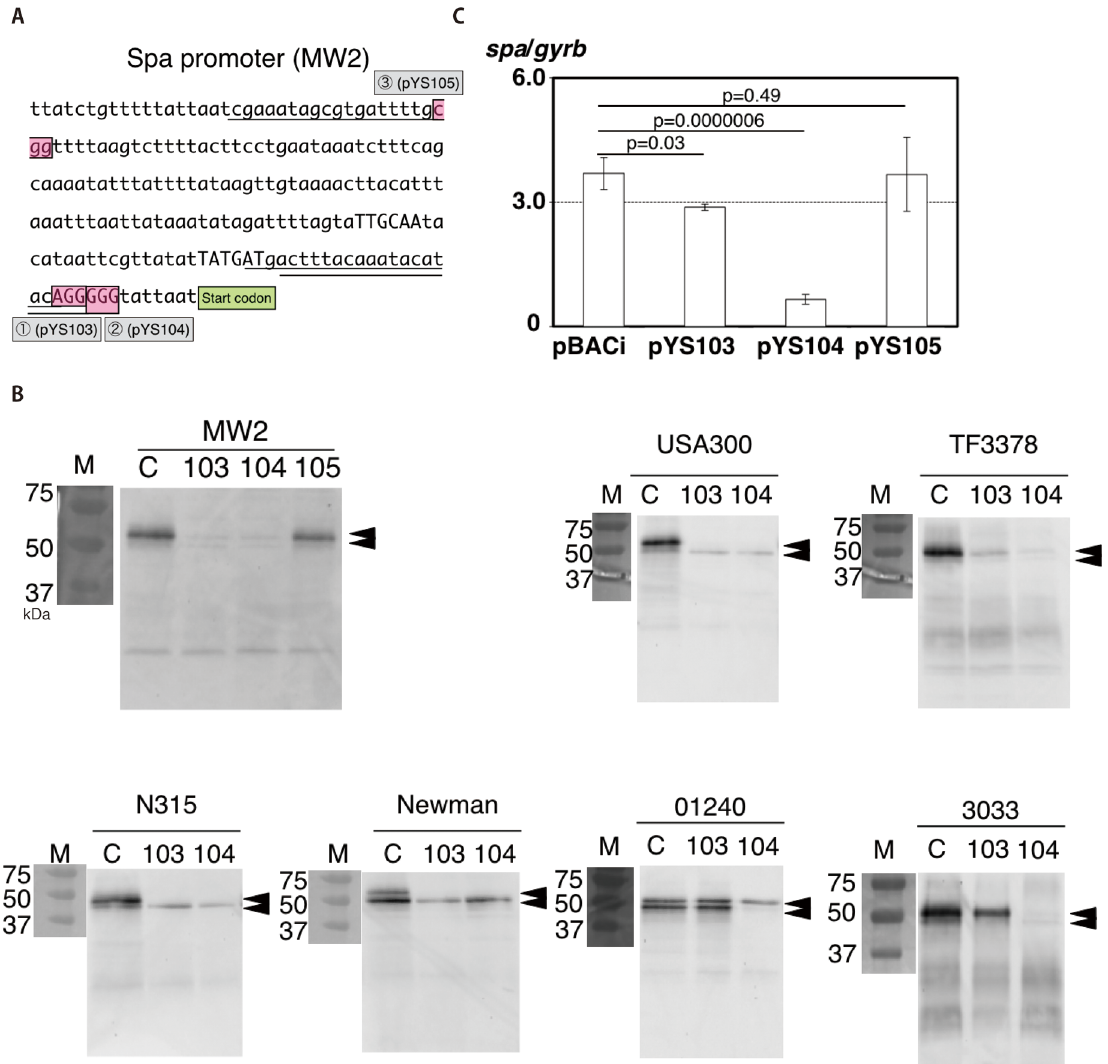
Fig 3. Staphylococcal protein A (Spa) silenced using CRISPRi. No significant growth inhibition was observed between the control and the silenced knockdown strains. pBACi (C): Vector control, pYS103 [103]: spa silenced knockdown vector 1, pYS104 [104]: spa silenced knockdown vector 2, pYS105 [105]: spa silenced knockdown vector 3. 3A. The upstream sequence of spa in MW2 and nucleotide sequences corresponding to spacer sequences. The partial sequence between spa (MW0084) and sarS (MW0085) in MW2 (Accession number: BA000033) is shown (101,008 bp-101,207 bp in MW2). Underline: spacer sequence [1–3], red boxes: PAM sequence (NGG), start codon: start codon of spa (ttg), capital letters: putative -35b, -10b and SD sequence (ribosome binding site) of spa in MW2. 3B. Western blotting to detect Spa in vector controls and silenced knockdown strains. Seven strains were analyzed. Three independent cultures from a single colony were performed and representative data are shown. Brackets indicate Protein A. Due to posttranslational processing of the cell surface-exposed ProteinA, some strains show double bands. “Plasmid No.” indicates serial pYS number plasmid used in this study (see S1 File). M: molecular marker. 75, 50 and 37 mean 75kDa, 50kDa and 37kDa bands, respectively. C: pBACi control vector (No crRNA coding region for spa silencing), pYS103-105: silencing CRISPRi vector containing the nucleotide sequence 1–3 corresponding to Fig 3A. Arrow heads: Spa. Two bands were found. This might result from processed/non-processed bands [52]. 3C. Repression of spa mRNA in MW2 using CRISPRi. Relative spa gene expression (/ gyrB )is shown. MW2/pBACi, MW2/pYS103, MW2/pYS104 and MW2/pYS105 were independently cultured three times. Three independent qPCR were performed (n = 9/strain). The average and SE are shown. Statistics: Student’s t